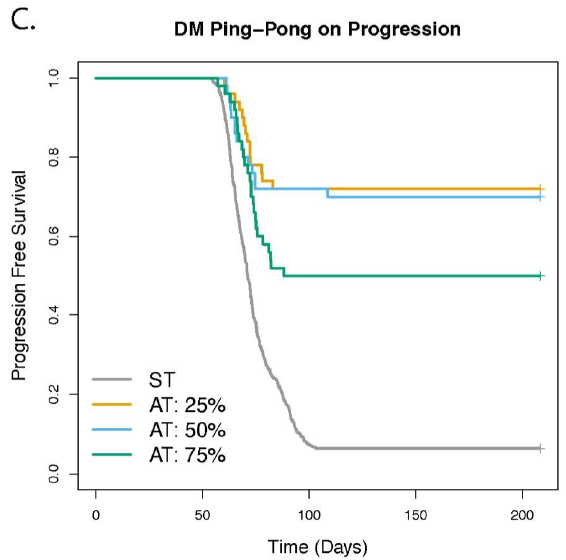
Figure 9. Role of the Delta Dose parameter for dose modulation (DM) adaptive therapy protocols. The panels show the comparison of adaptive therapy (AT) versus standard treatment (ST) as the Delta Dose parameter is varied for ( A ) DM Cocktail Tandem, ( B ) DM Ping-Pong Alternate Every Cycle, ( C ) DM Ping-Pong on Progression. Delta Dose is the percentage by which the drug dose is changed (increased or decreased) relative to the last time the same drug was administered. Default value is 50% for both